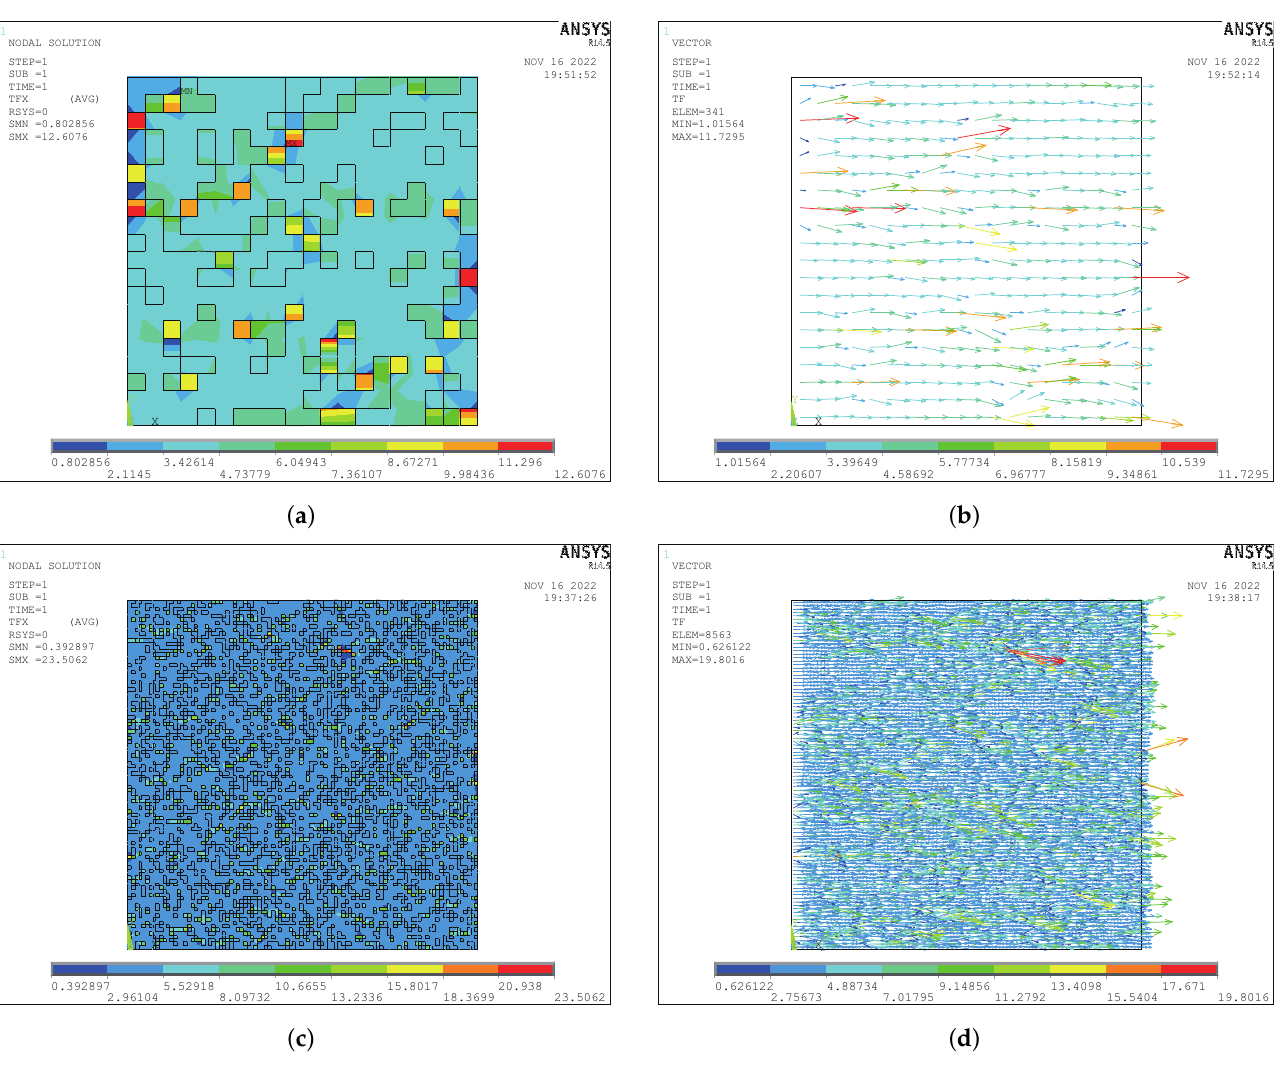
Figure 8. Calculation results of thermal conductivity of the improved GCIB: ( a ) the heat flow density cloud chart (400 units); ( b ) the heat flow density vector chart (400 units); ( c ) the heat flow density cloud chart (10,000 units); ( d ) the heat flow density vector chart (10,000